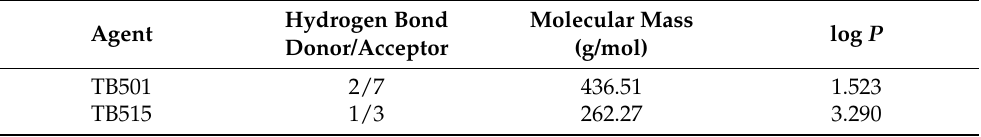
Figure 5. Chemical structure of the two in silico identified small molecular weight trisubstituted coumaran (2,3- dihydrobenzofuran) antitubercular agent candidates: TB501 and TB515. Table 7. Chemical features of the two in silico identified small molecular weight antitubercular agent candidates.